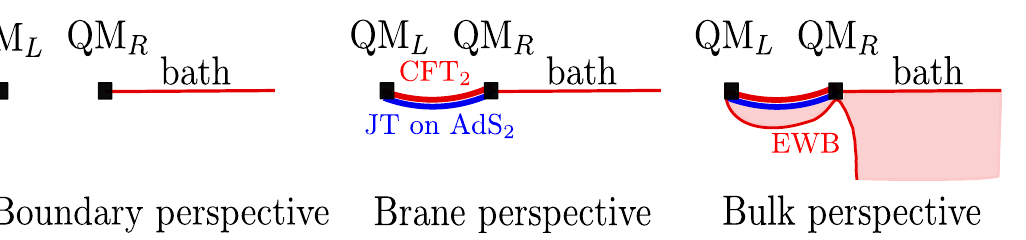
Figure 1. Evaporating black hole coupled to a bath from 3 different